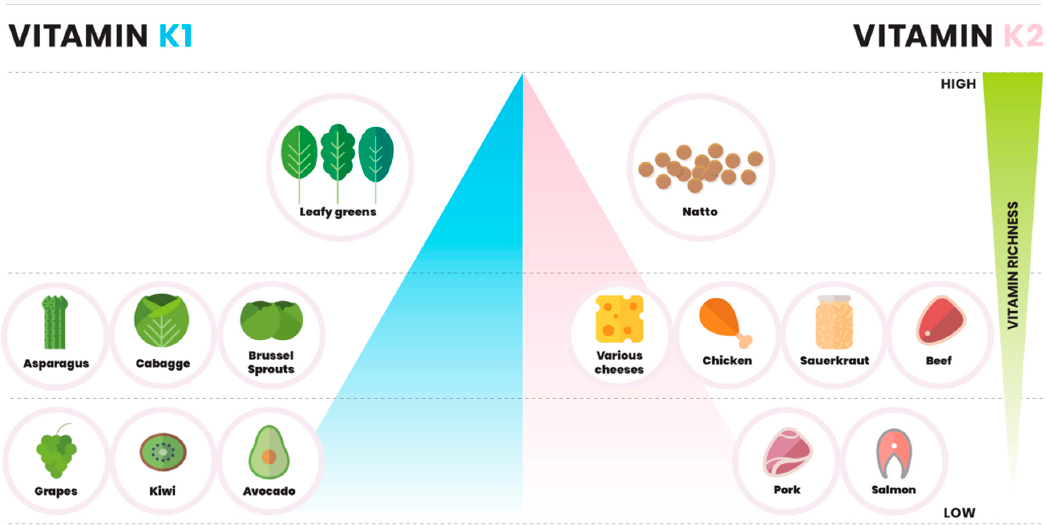
Figure 1. Dietary sources of vitamin K. Left side of pyramid displays K1 content gradient in dietary sources of vitamin K1. Leafy greens include spinach, kale and swiss shards. Right side visualizes K2 content gradient with natto being the most significant source. Various cheeses include hard and soft cheeses with K2 content being dependent on fermentation level.